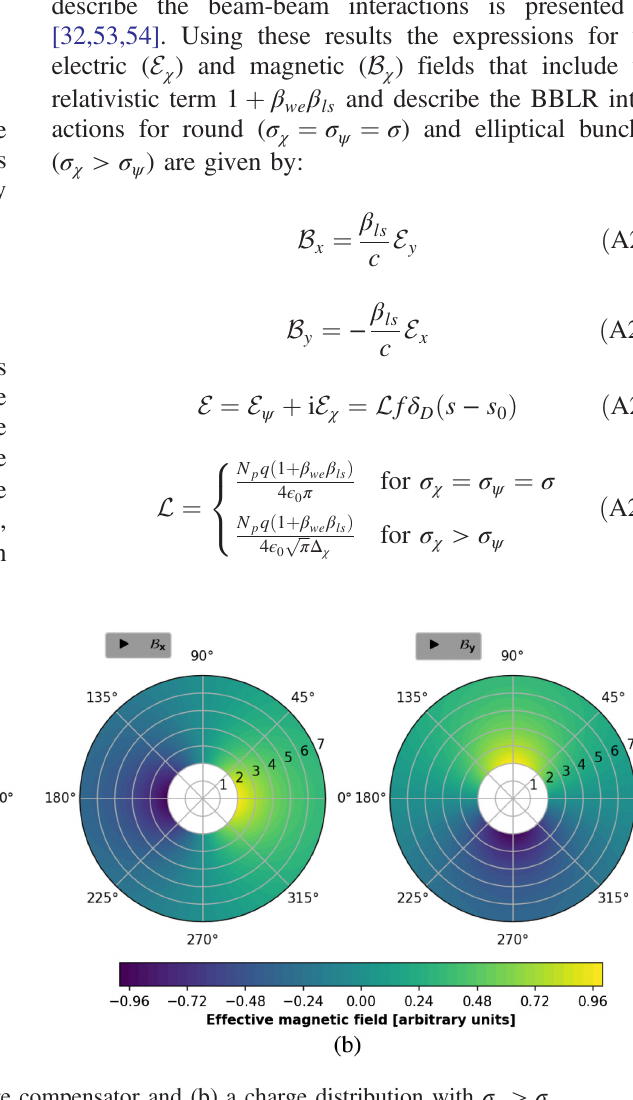
FIG. 12. Transverse magnetic field from: (a) a wire compensator and (b) a charge distribution with σ x > σ y